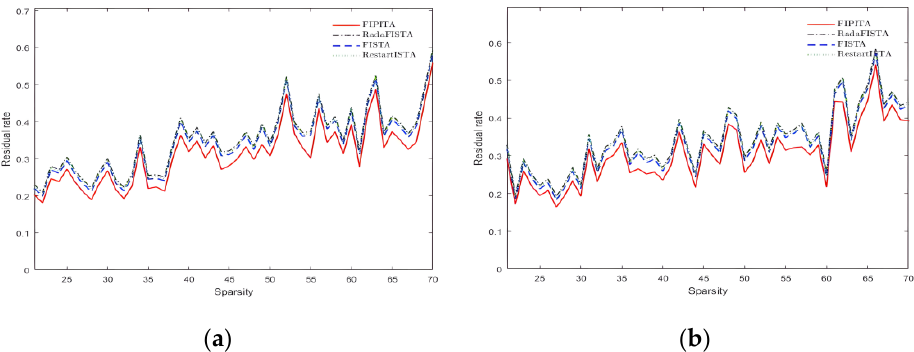
Figure 7. Signal residual rate under different sparsity. ( a ) Residual rate of Hadamard matrix; ( b ) residual rate of Gaussian matrix.